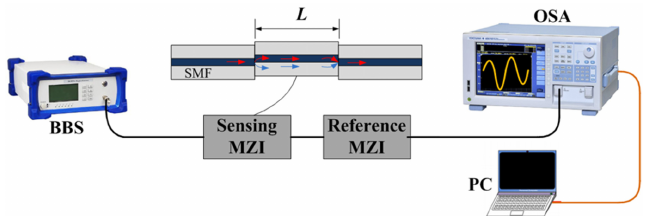
Figure 6. Experimental setup of the cascaded in-line MZIs [9]. Reprinted with permission from Ref. [9] ©The Optical